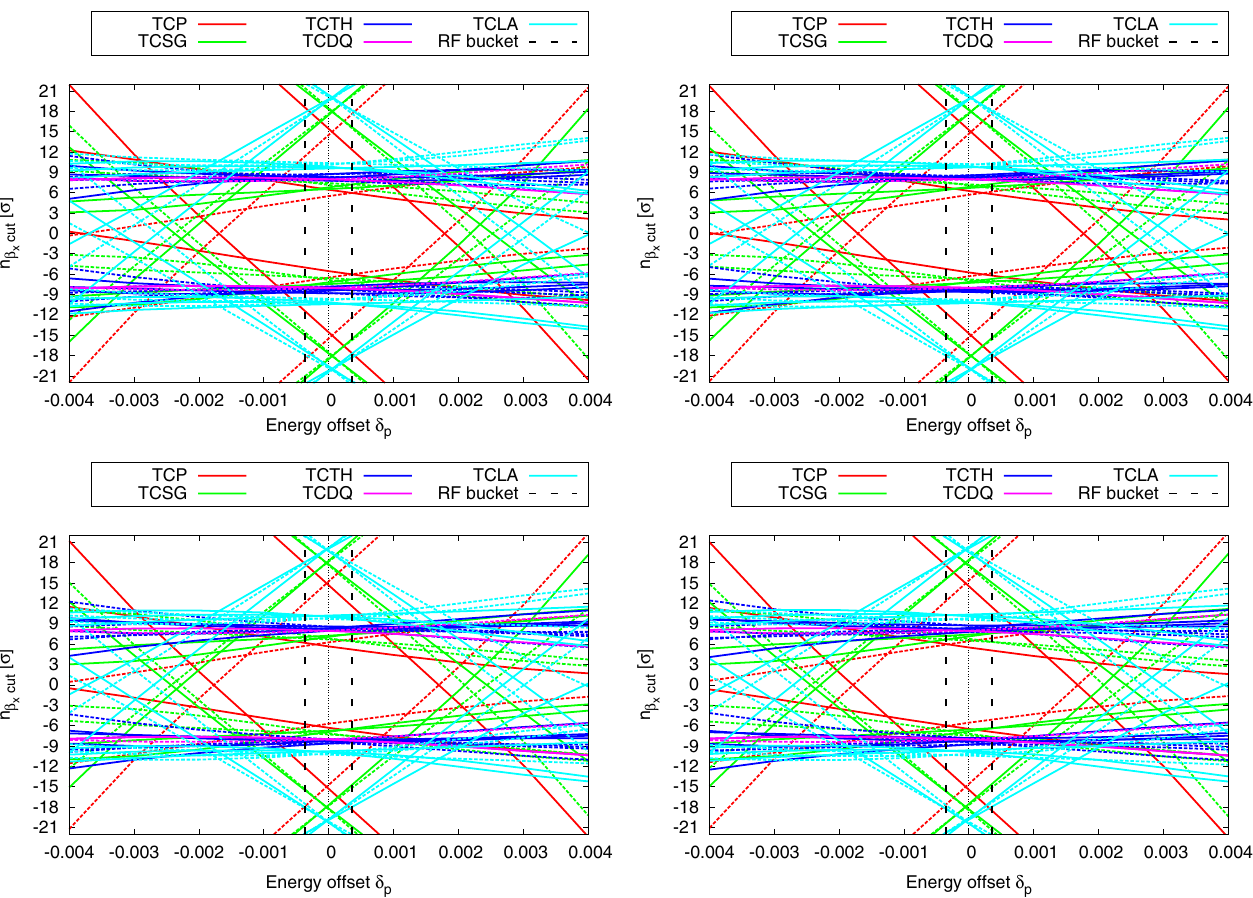
FIG. 11. (Color) CC disturbed phase space cut, with the hierarchy of primary (TCP), secondary (TCSG), tertiary (TCTH), beam dump (TCDQ) horizontal collimators, and shower absorbers (TCLA): longitudinal slice with z ¼ 1 (cid:7) z (top left); longitudinal slice with z ¼ 3 (cid:7) z ¼ 4 (cid:7) z ¼ 2 (cid:7) z (top right); longitudinal slice with z (bottom left); longitudinal slice with z (bottom